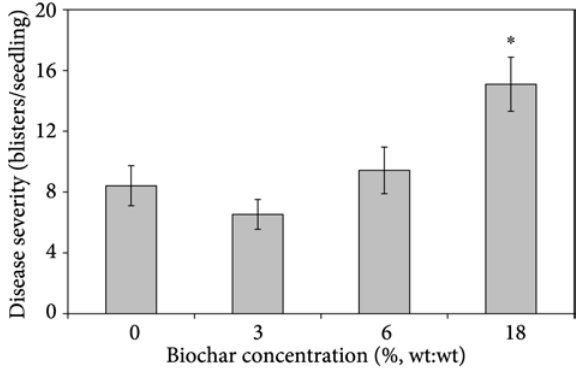
Fig. 1. The influence of increasing greenhouse waste biochar concentrations (w/w) on the disease severity caused by Clavibacter michiganensis subsp. michiganensis on tomato seedlings. Tomato cv. Fantasia was grown from seeds in commercial nursery. 17 days after sawing, seedlings were inoculated until runoff with 10 8 CFU/ml. Disease severities as white blisters on leaves were counted on each plant 8 days after inoculation. Vertical lines = Standard error. Asterisk represents treatment which is significantly different from the rest of the treatments by using Tukey HSD test ( α =